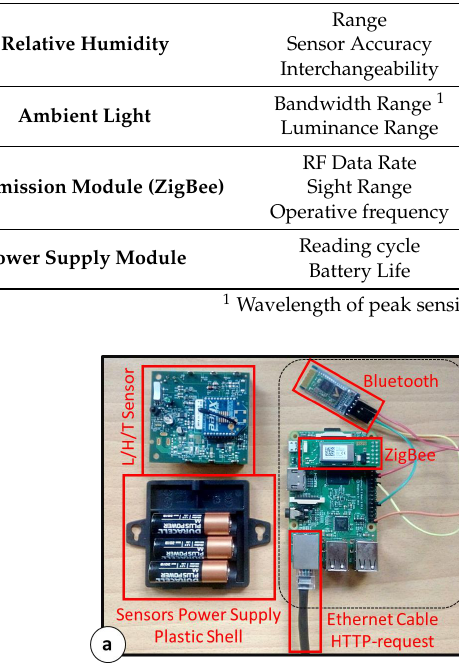
Table 1. L/H/T Sensors and dedicated modules performance.